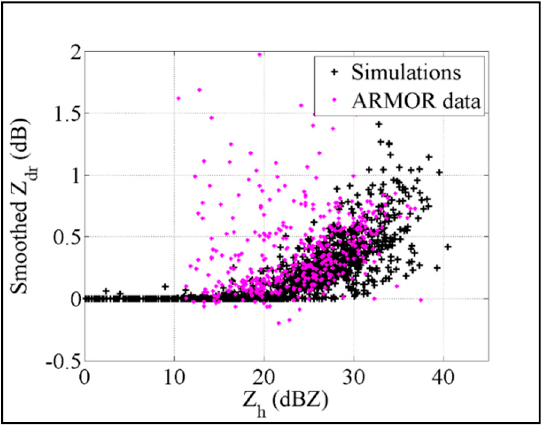
Figure 10. Z versus Z dr corresponding to Figure 9.